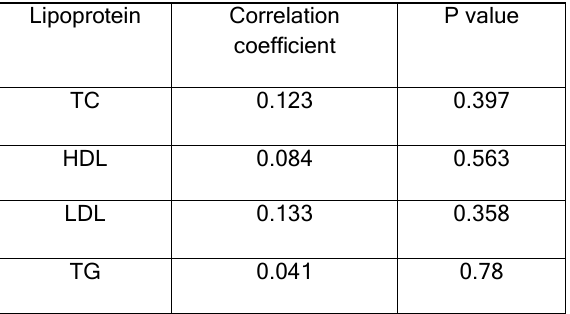
Table-. 4 -Person correlation between WBC count